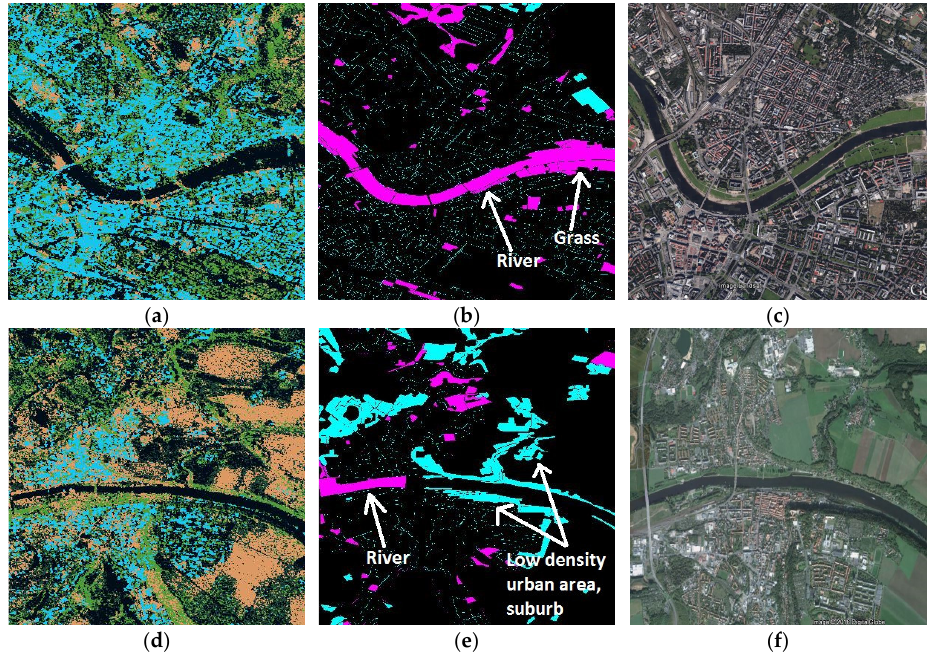
Figure 8. Dresden area, misclassification sources. ( a ) The Elbe River as seen on the Level-1 β image. ( b ) Misclassification map. ( c ) Google Earth view. ( d ) A small urban area in the neighborhood of the Elbe River as seen on the clustered Level-1 β product. ( e ) Misclassification map. ( f ) Google Earth view. The river is incorrectly classified as an urban area, as well as the adjacent grassland stripe. However, this classification is congruent with the given definition of urban